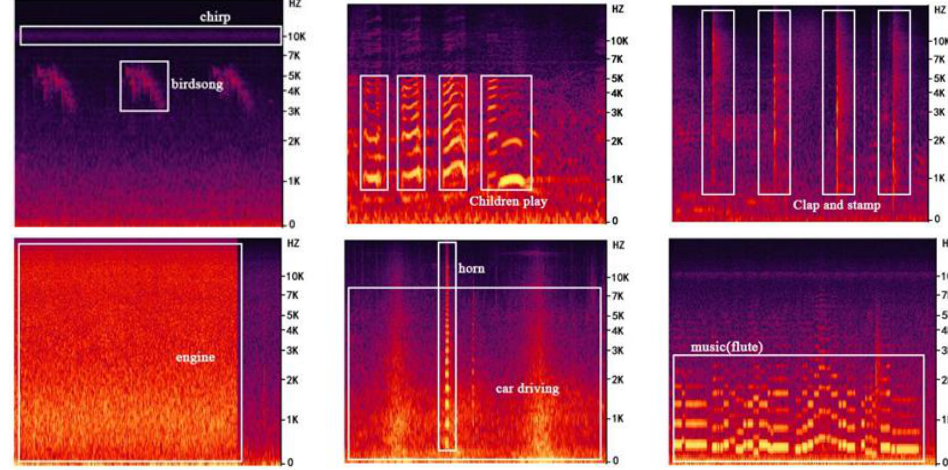
Figure 3. Schematic diagram of sound spectrum recognition in each frequency band.